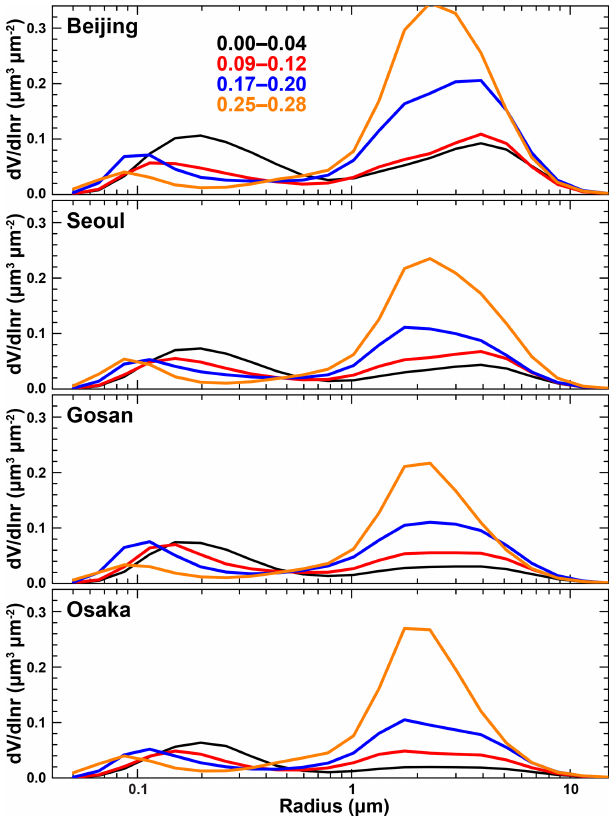
Figure 2. The mean volume particle size distributions for different ranges of PLDR for the East Asian AERONET sites considered in this